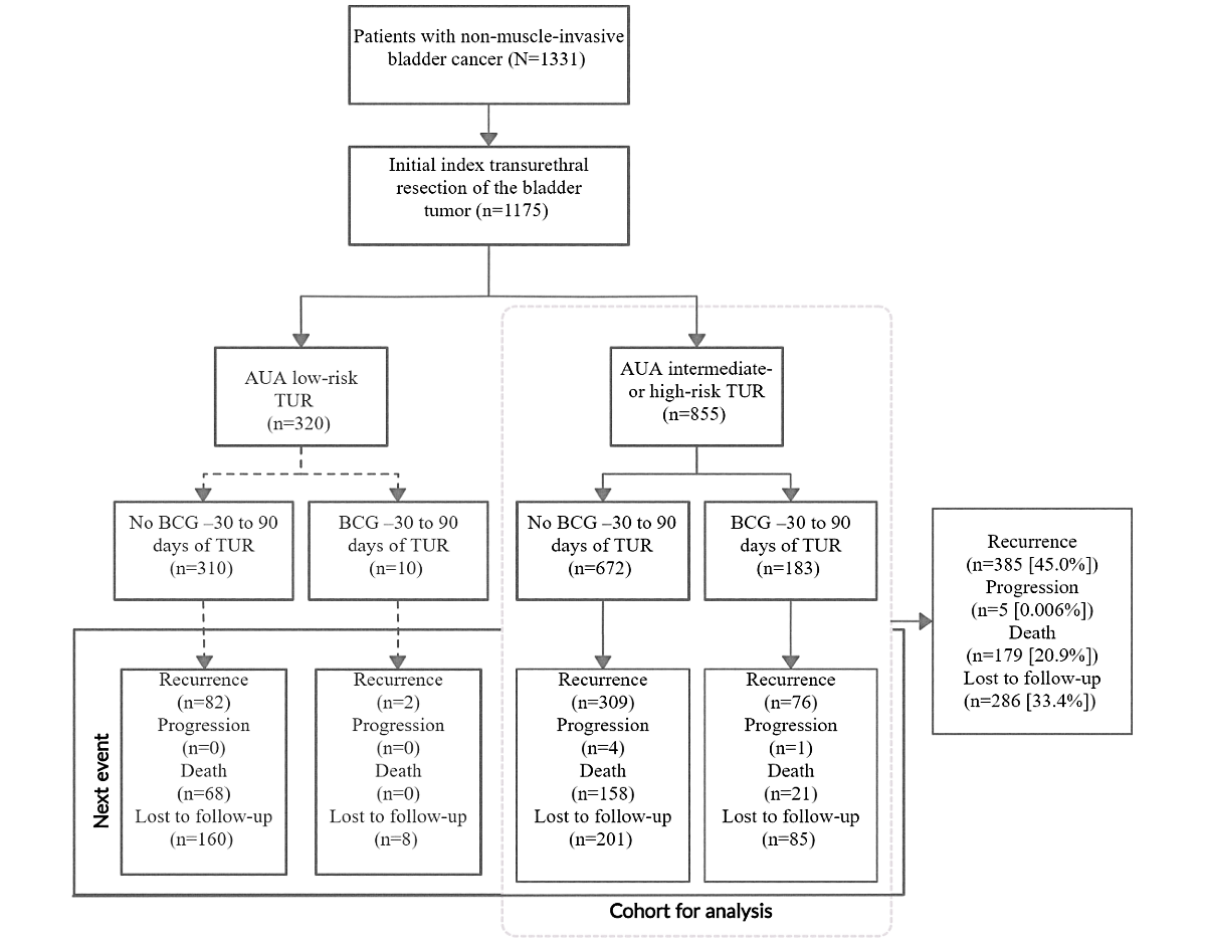
Figure 1. Patient flowchart. AUA: American Urological Association; BCG: bacillus Calmette-Guérin; TUR: transurethral resection of a bladder